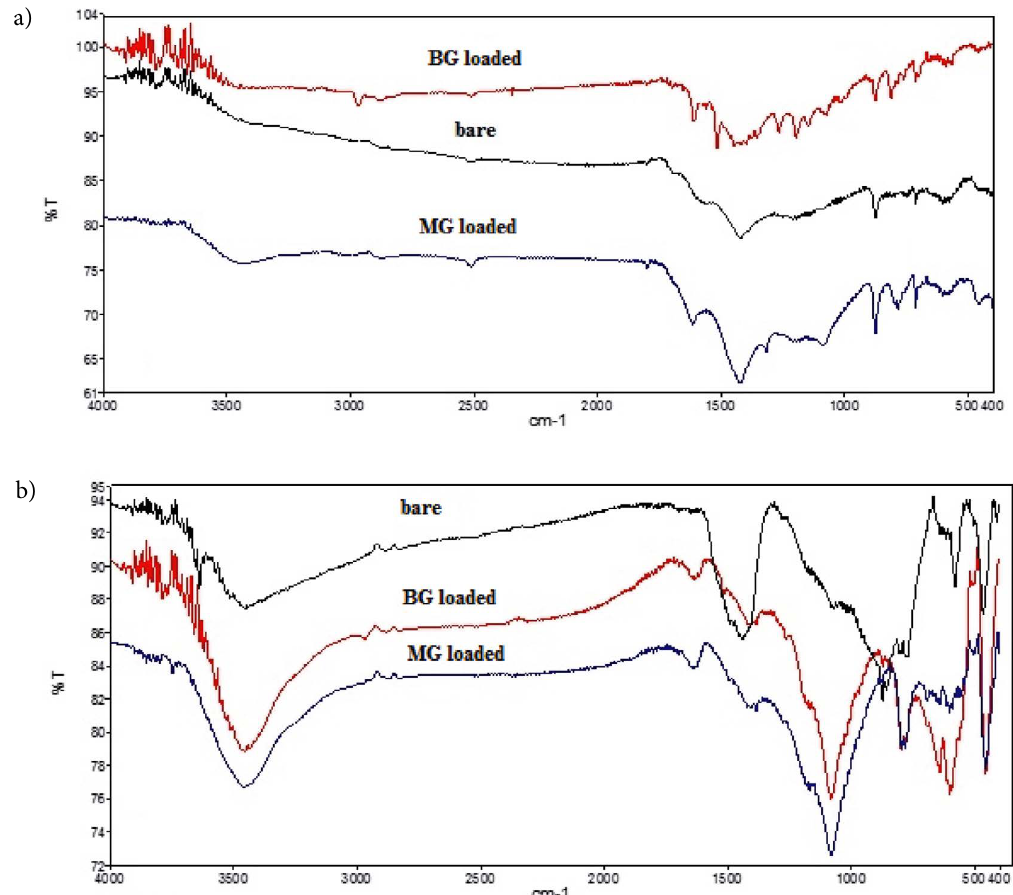
Figure 3. FTIR spectra of adsorbents before and after dye adsorption a) SW500 and b)